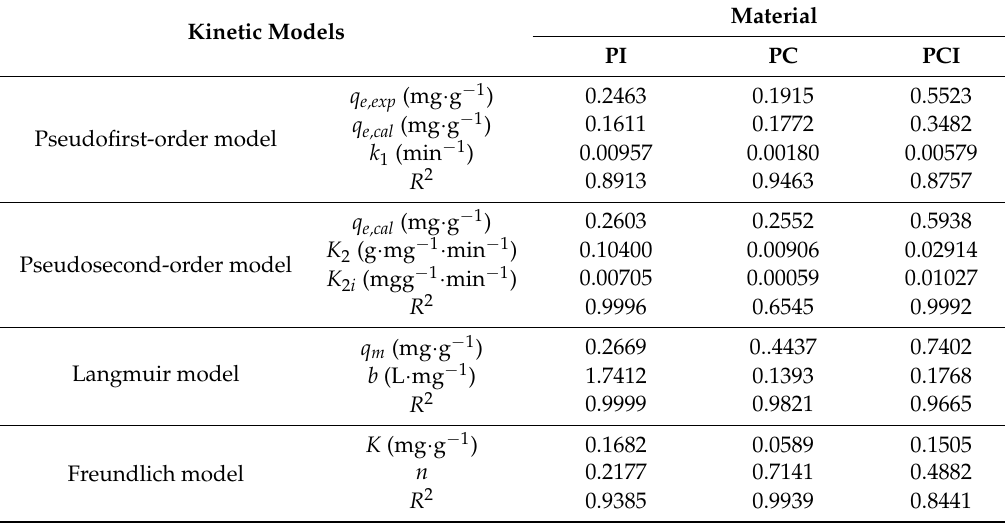
Table 1. Kinetic calculations results for pseudo-first; second-order models; Langmuir and Freundlichmodels by